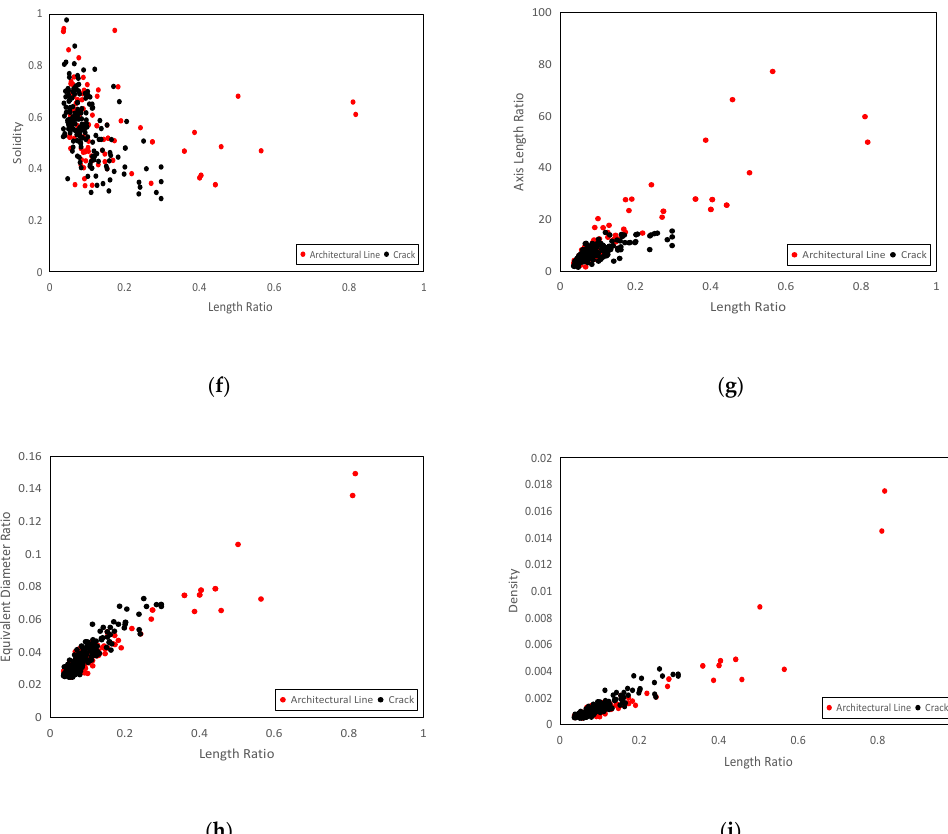
Figure 12. Data for classifier evaluation framework. ( a ) Geometry of cracks and architectural lines, ( b ) Extent-length ratio, ( c ) orientation ratio-length ratio, ( d ) width ratio-length ratio, ( e ) convex area ratio-length ratio, ( f ) solidity-length ratio, ( g ) axis ratio-length ratio, ( h ) equivalent diameter ratio-length ratio and ( i ) density-length ratio.